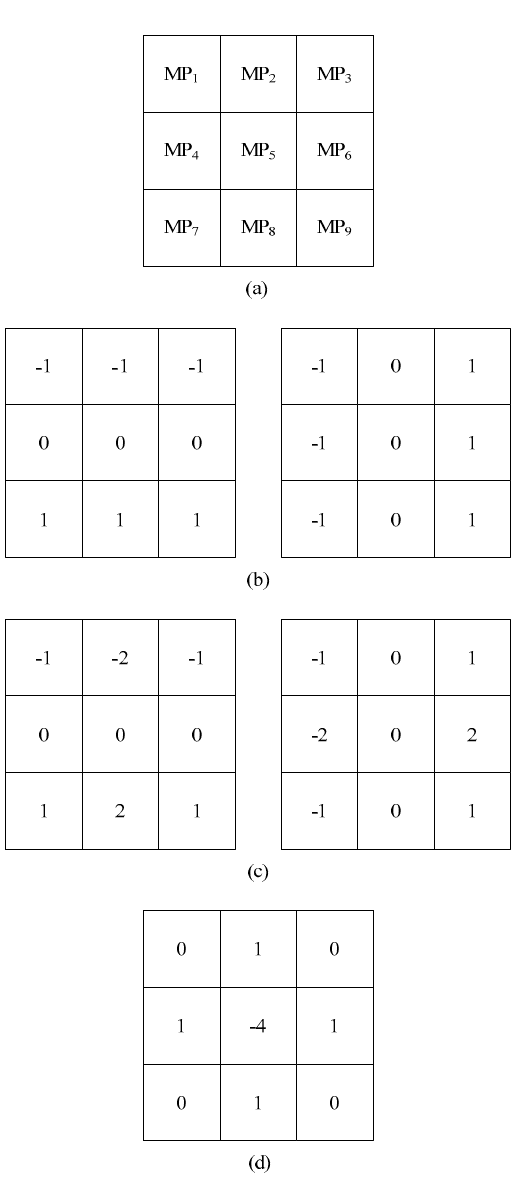
Figure 2. The neighborhood of the mixed pixel and classic edge detection masks. ( a ) The neighborhood of the mixed pixel; ( b ) Prewitt; ( c ) Sobel; ( d ) Laplacian edge detection masks. Due to high discontinuity of gray values, mixed pixels with highly curled edge are usually difficult for SUIM. However, they are also the key part of SUIM that has a potential to be better mapped in order to improve SUIM accuracy. In this study, NEII acts as a threshold to switch a current mixed pixel between two different processing models. If the NEII value of a mixed pixel is larger than a given threshold, SAMENN ‐ SUIM constructs ENN ‐ SUIM to acquire the spatial distributions of urban inundation at a sub ‐ pixel scale. Otherwise, SAMENN ‐ SUIM uses SAM to get the sub ‐ pixel mapping results. Figure 3 shows the flow chart of SAMENN ‐ SUIM.